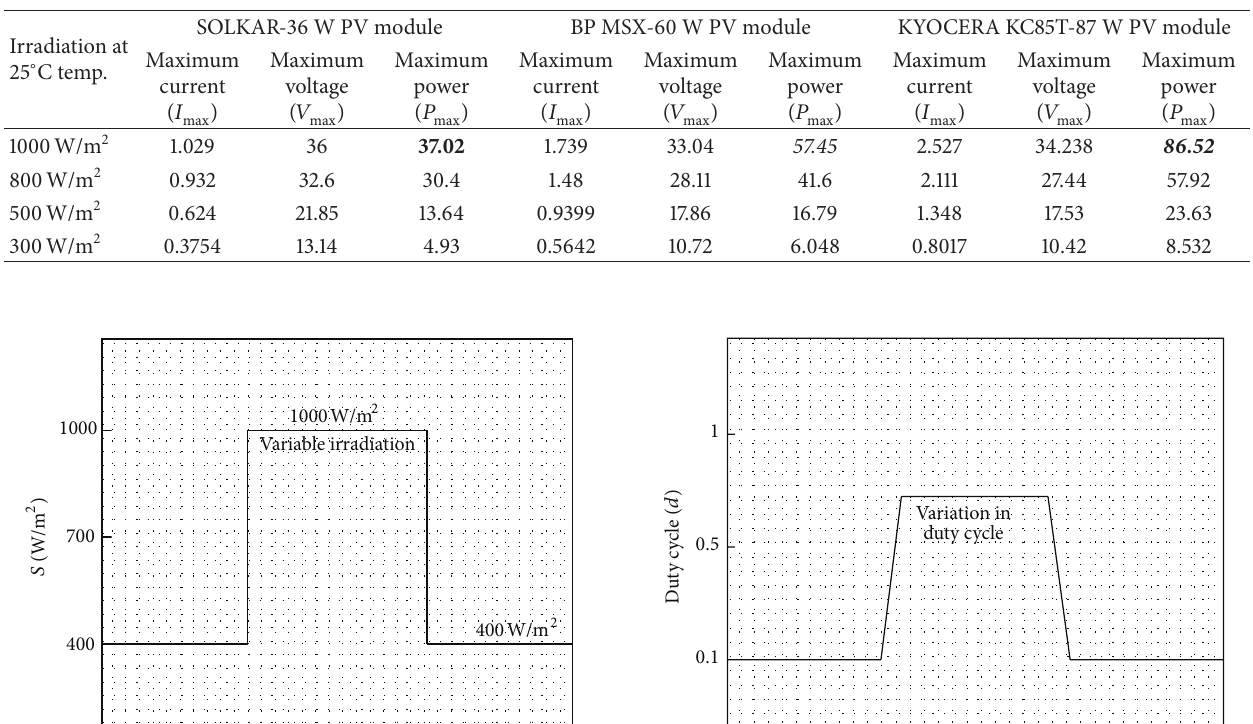
Figure 17: Complete system implementation in Simulink for data analysis. Table 2: The resultant output voltage, current, and power at different irradiation for standard test temp (25 ∘ C) for the selected three PV modules.